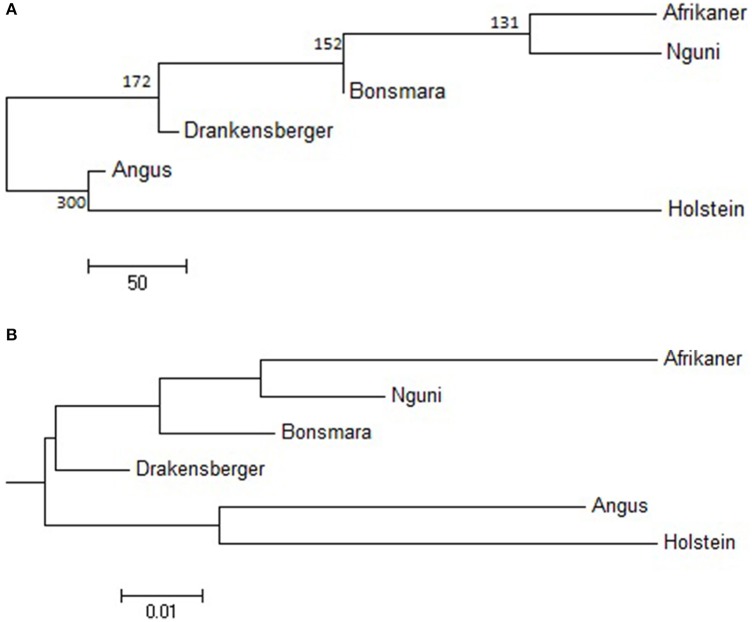
(A) Neighbor-joining tree showing time since breed divergence in generations, (B) Neighbor-joining tree showing the genetic relationship among breeds based on FST.